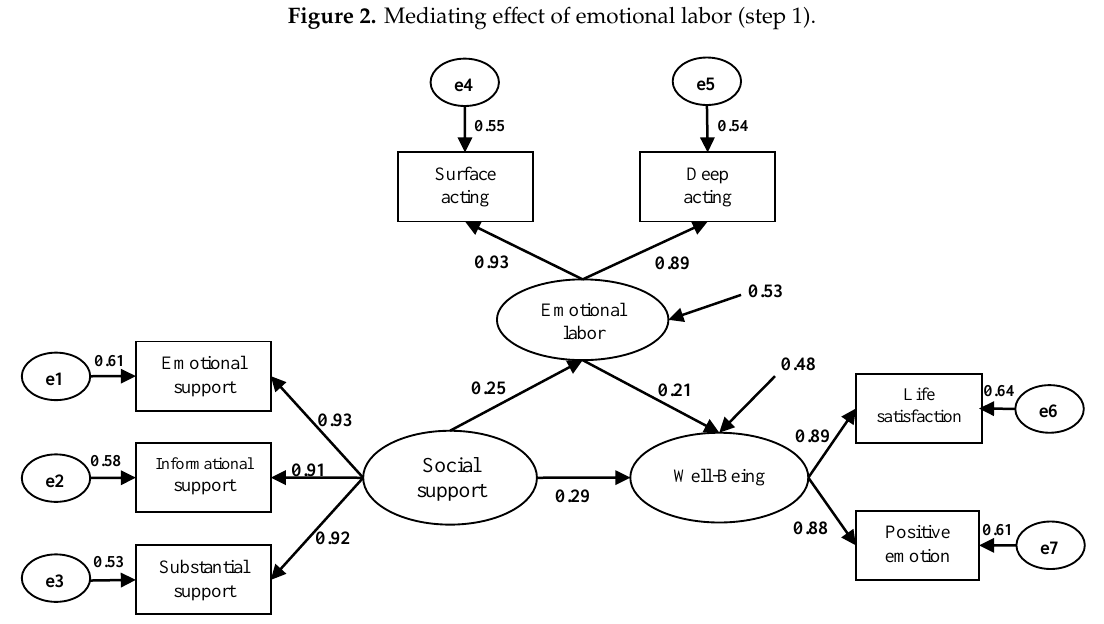
ff ect of emotional labor (step Figure 3. Mediating effect of emotional labor (step 2). Figure 3. Mediating e